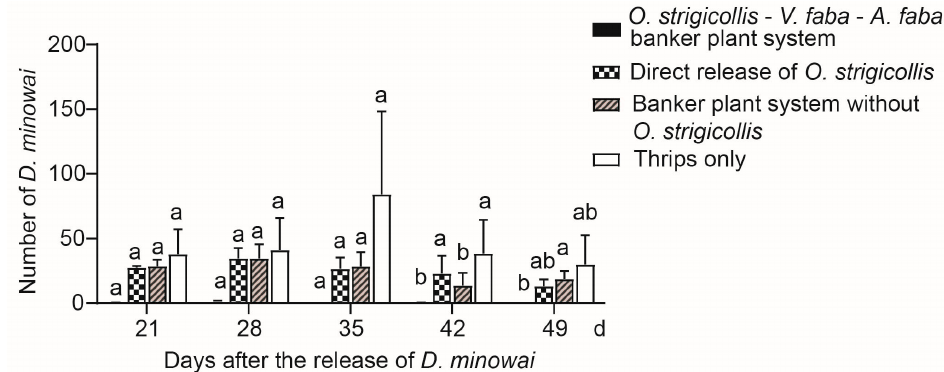
Figure 3. Number of Dendrothrips minowai on tea seedlings in the four treatments: (1) O. strigicollis–V. faba–A. fabae banker plant system, (2) direct release of O. strigicollis , (3) banker plant system without O. strigicollis , and (4) thrips only. Numbers of D. minowai were counted weekly for 4 weeks after releasing. Data are presented as mean ± SEM. Different letters indicate significant differences among the four treatments separately in each of the dates ( p < 0.05) calculated using Kruskal–Wallis tests followed by Dunn–Bonferroni